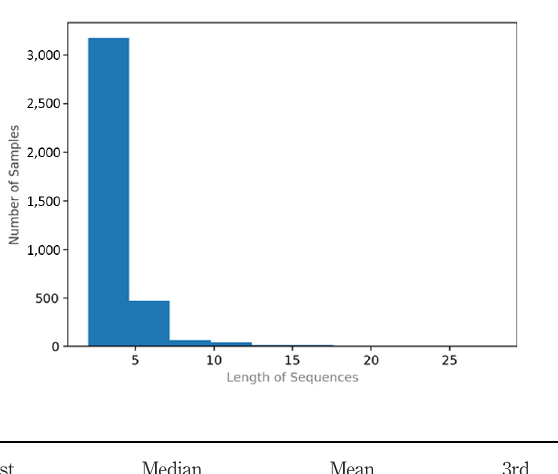
Table III. Sample age